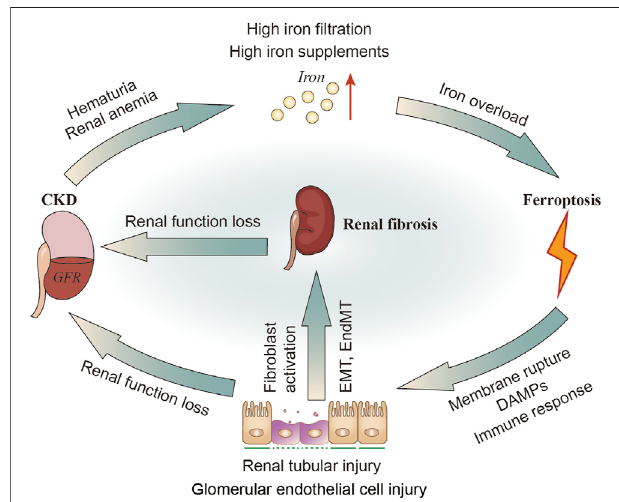
FIGURE4| TherelationshipofCKD,ironmetabolism,ferroptosisinrenal tubular cells and renal fi brosis. In patients with CKD, hematuria and renal anemia could cause increased iron fi ltration in renal tubules and excessive exogenous intake of iron. Iron overload may induce ferroptosis, leading torenalinjuryandDAMPs signalsreleaseaswellasin fl ammatoryand immune responses. The injured tubular can then activate fi broblasts or directly transform into myo fi broblasts through EMT. Kidney injury or renal fi brosis can further reduce the GFR. DAMPs, damage-related molecular patterns; GFR; glomerular fi ltration